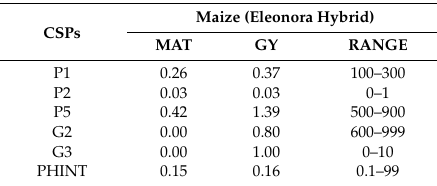
Table 6. Sensitivity index of the CSPs of CSM-CERES-Maize crop model for maturity date (MAT) and grain yield (GY) of Eleonora hybrid and range are considered.